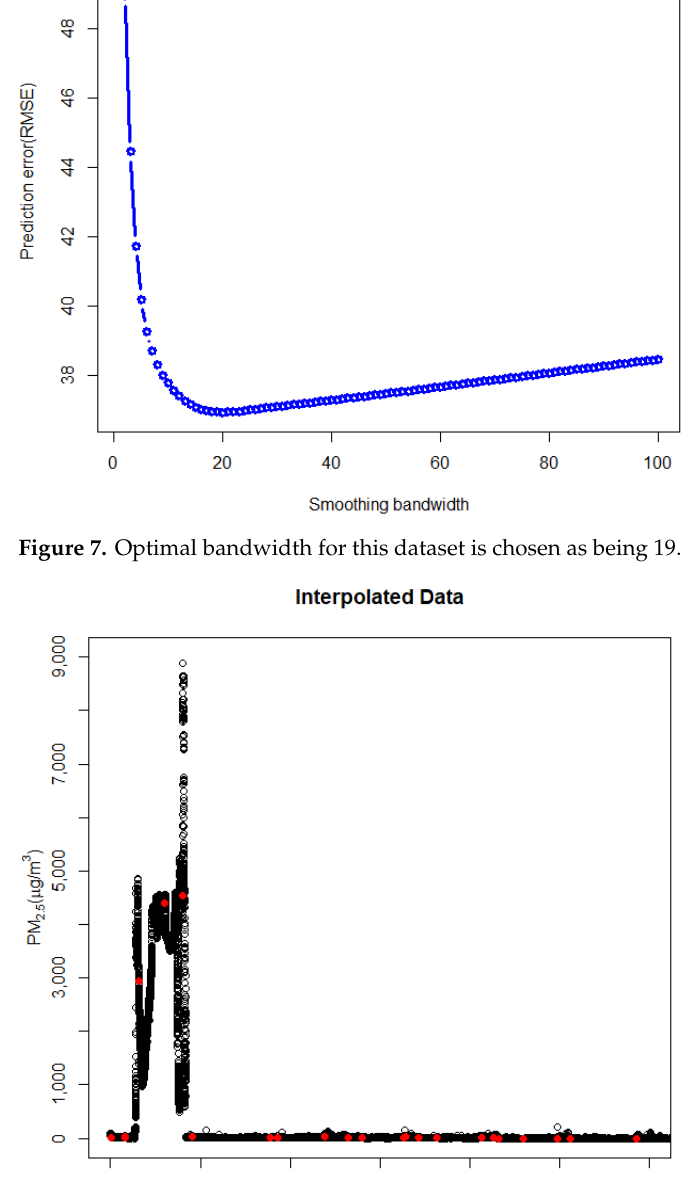
Figure 8. Missing data is interpolated and shown in red.